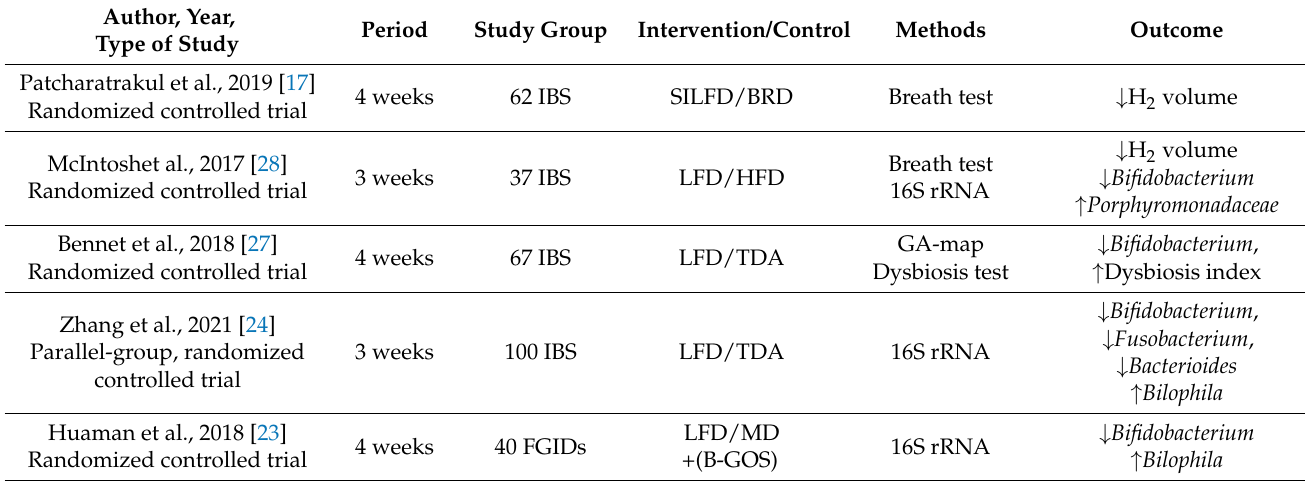
Table 1. Characteristics of included studies connected with a low-FODMAP diet on gut